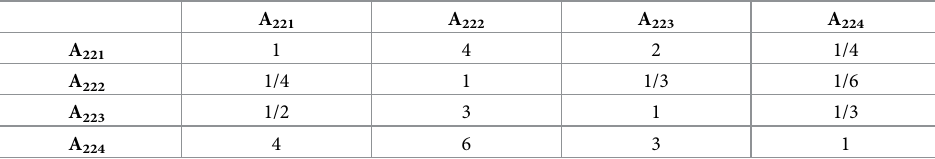
Table 11. Pairwise comparison matrix of the capital investment indexes.